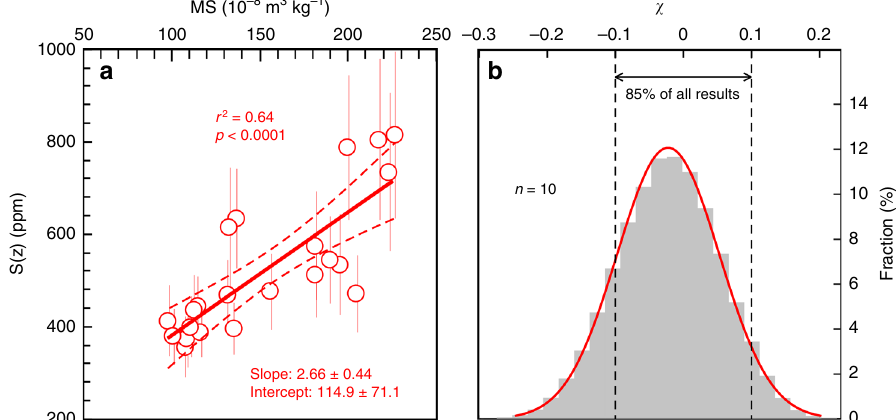
Fig. 2 The magnetic susceptibility (MS) – S ( z ) correlation of the Chinese Loess Plateau. a Back-calculated S ( z ) values plotted against MS from Luochuan paleosol samples spanning the last 800 ky. Error bars represent 1 σ errors resulted from Monte Carlo simulations (Supplementary Note 1). The best fi tting line, as well as 95% con fi dence interval are indicated by red solid and dotted lines, respectively. b Histogram of the mean relative differences ( χ ) between calculated and ice core p CO 2 , when the sample numbers in the training group ( n ) is set to